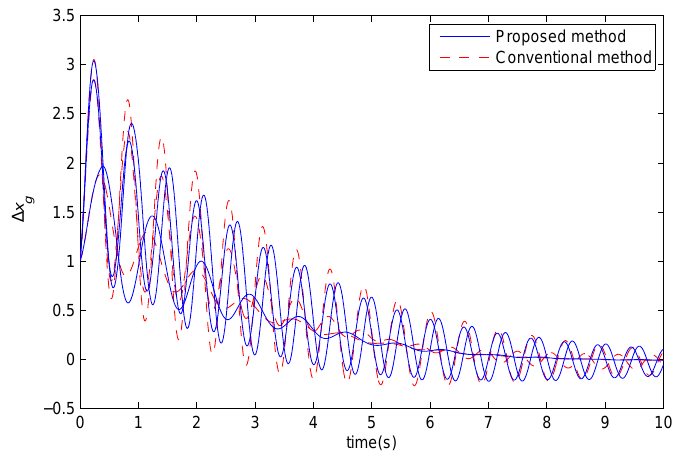
Figure 10. The governor input of the gas turbine generator ∆ x g .